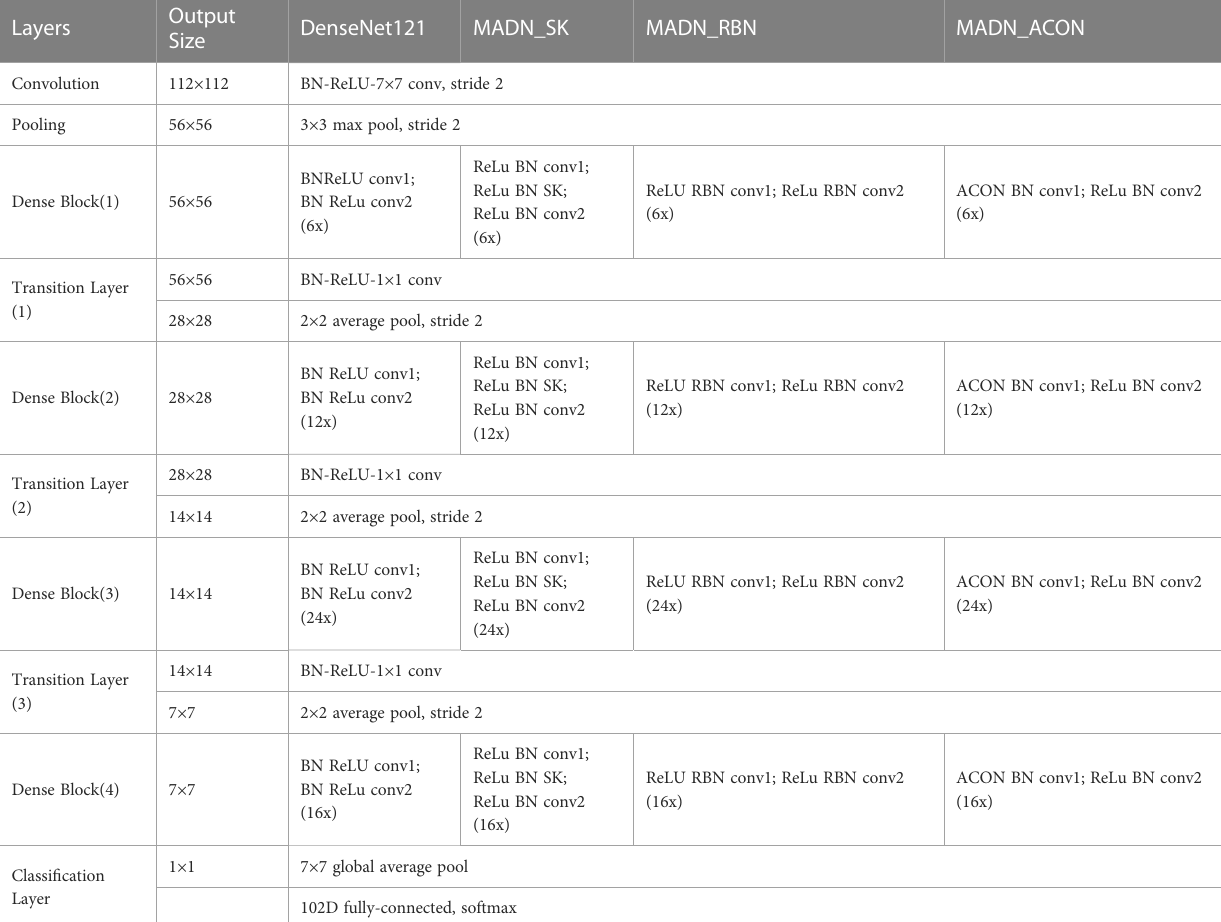
TABLE 2 Structural comparison of DenseNet-121 and modi fi ed models.